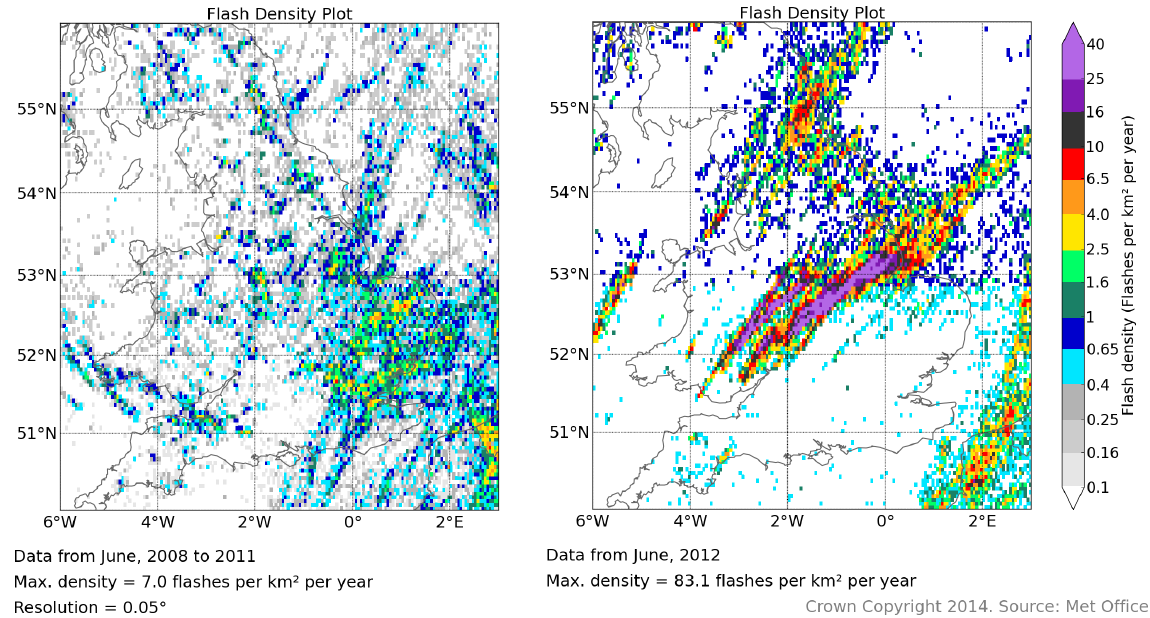
Fig. 17. Detected lightning flash density for June for the UK, between 2008 and 2011 (left), and in 2012 only